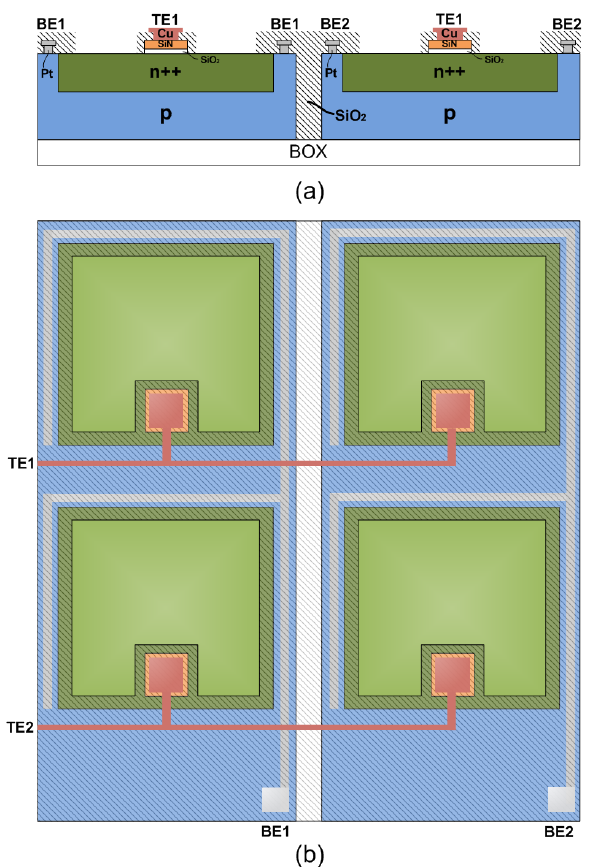
Figure 8. 1D1M vision sensor’s schematic layout: ( a ) 2 adjacent pixels of the same row cross section view; ( b ) 2 × 2 sensor’s pixel array top view. 3.3. SPICE Simulated in-memory-computing operations.